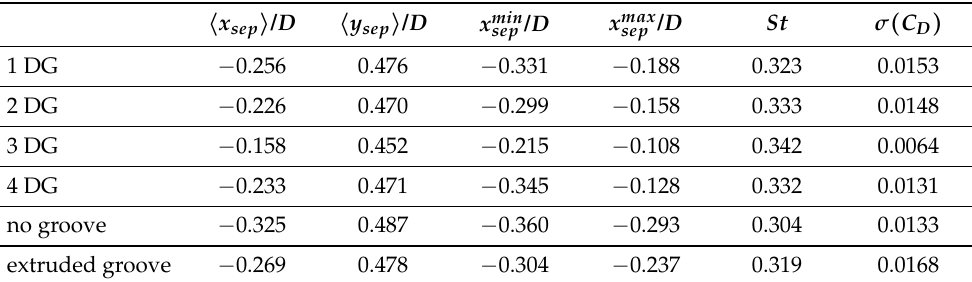
Figure 8. Spanwise distributions of ( x sep , y ) (orange continuous line) and of the minimum and sep maximum values of ( x sep , y sep ) during the vortex-shedding cycle (orange dashed lines). Cases: ( a ) N = 1, ( b ) N = 2, ( c ) N = 3, and ( d ) N = 4. The cross-section considered to evaluate the pressure coefficient distributions in Figure 9 are also sketched. Table 2. Mean separation point and its maximum variation during a vortex-shedding cycle, vortex- shedding Strouhal number and the standard deviation of the drag coefficients. The results for the boat-tail without the groove and for the extruded groove are from